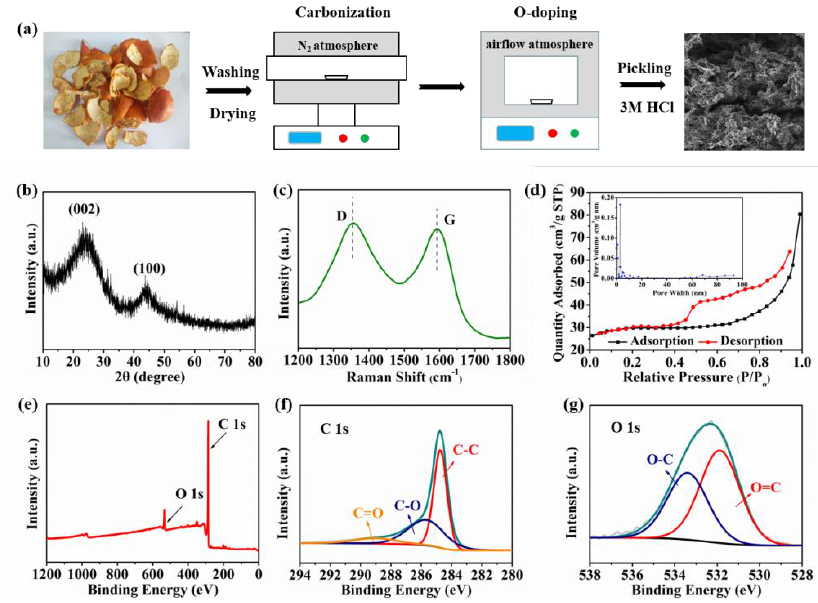
Figure 1. ( a ) Preparation scheme of OPDC. ( b ) XRD pattern. ( c ) Raman spectrum. ( d ) N 2 adsorp- tion/desorption isotherms and pore size distribution. ( e ) Survey XPS spectrum, ( f ) high-resolution C 1s XPS spectra, and ( g ) high-resolution O 1s XPS spectra of OPDC.